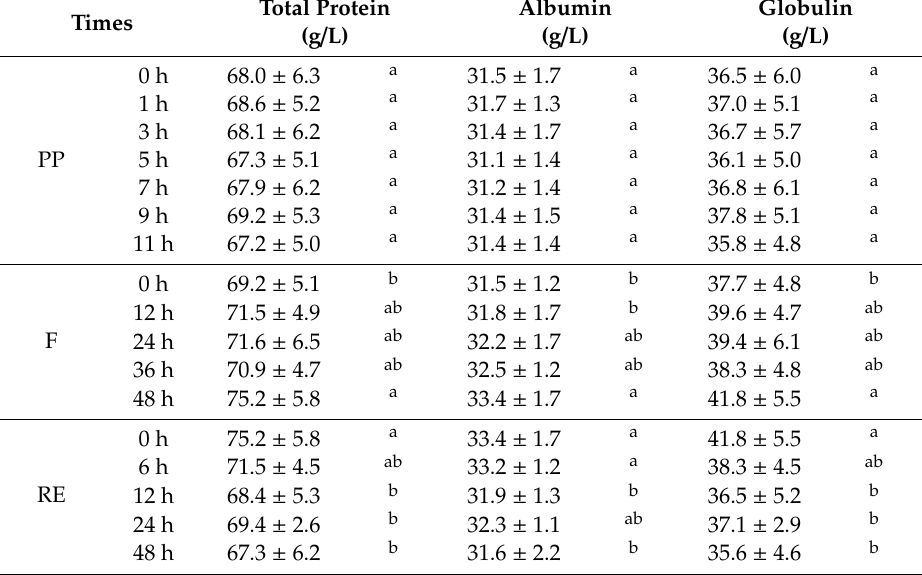
Table 4. Mean values and standard deviations of serum concentrations of total protein, albumin, and globulin of cattle in the postprandial periods (PP), fasting (F), and re-feeding (RF). Total Protein Times